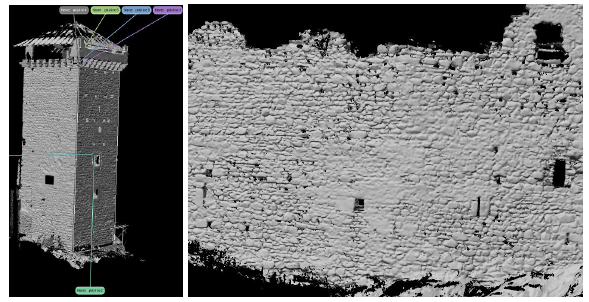
Figure 5: A geometric detail of a modelled tower and